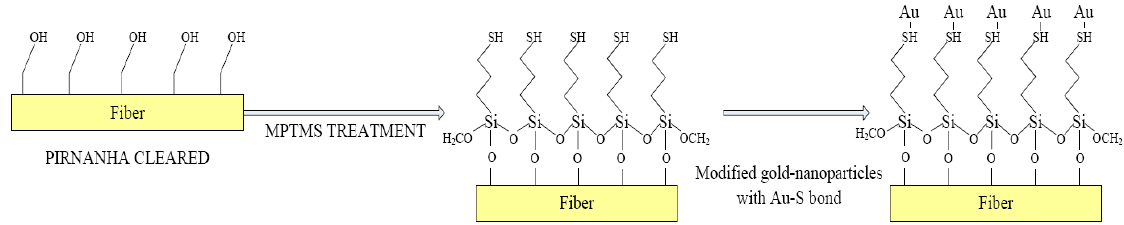
Figure 4. Schematic of gold nanoparticle self-assembly in